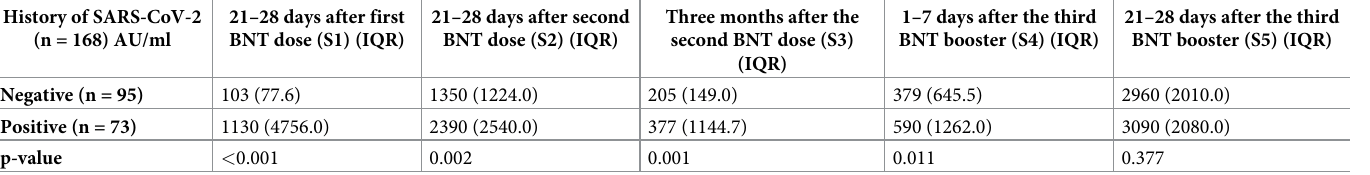
infection), there is a statistical increase (p < 0.001). Table 3 presents the median (IQR) of the quantitative SARS-CoV-2 IgG antibody titers once the participants were divided into two groups according to their history of SARS-CoV-2 infection. Table 3. Quantitative SARS-CoV-2 spike 1–2 IgG antibody titers against SARS-CoV-2 in participants with a positive or negative history of SARS-CoV-2 infection. History of SARS-CoV-2 (n = 168)